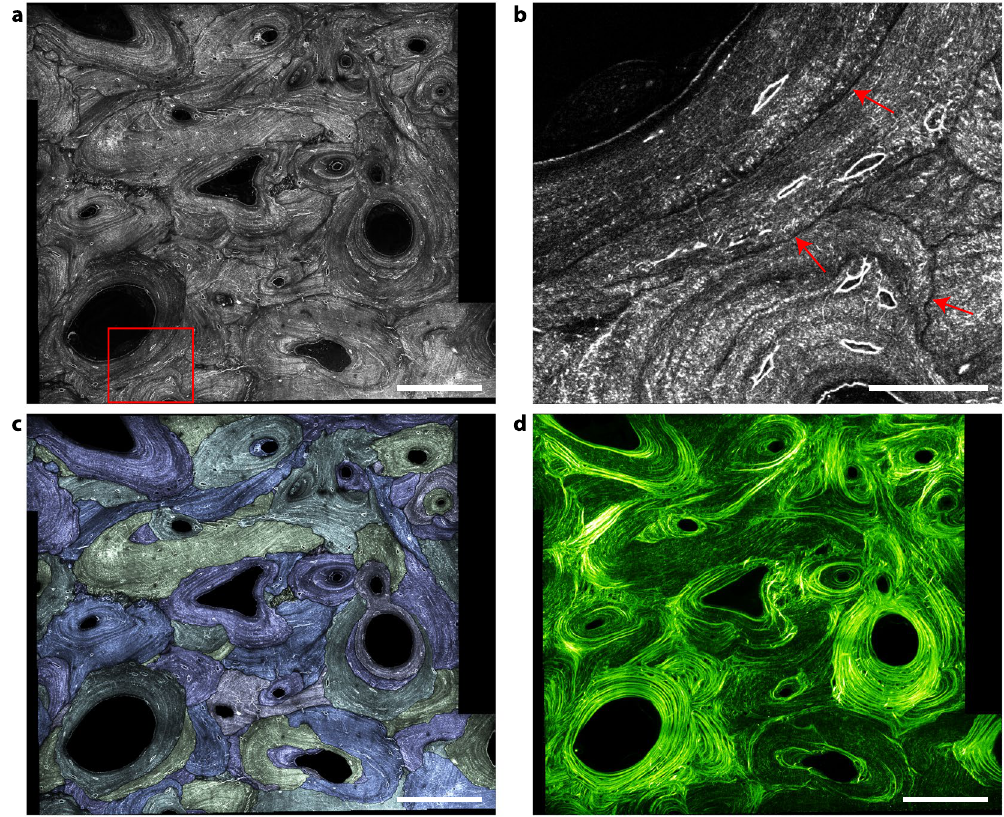
Figure 8. Segmentation of bone structural units using THG images. ( a ) Mosaic THG image of a human femoral cortical bone exhibiting extensive remodeling. ( b ) Zoom into the red rectangle in ( a ) showing the dip in the THG signal used to segment BSUs (red arrows). ( c ) Segmented THG with the different BSUs displayed using different colors. ( d ) Corresponding SHG image. Scale bars, 200 µ m in ( a – c ); 50 µ m in ( b